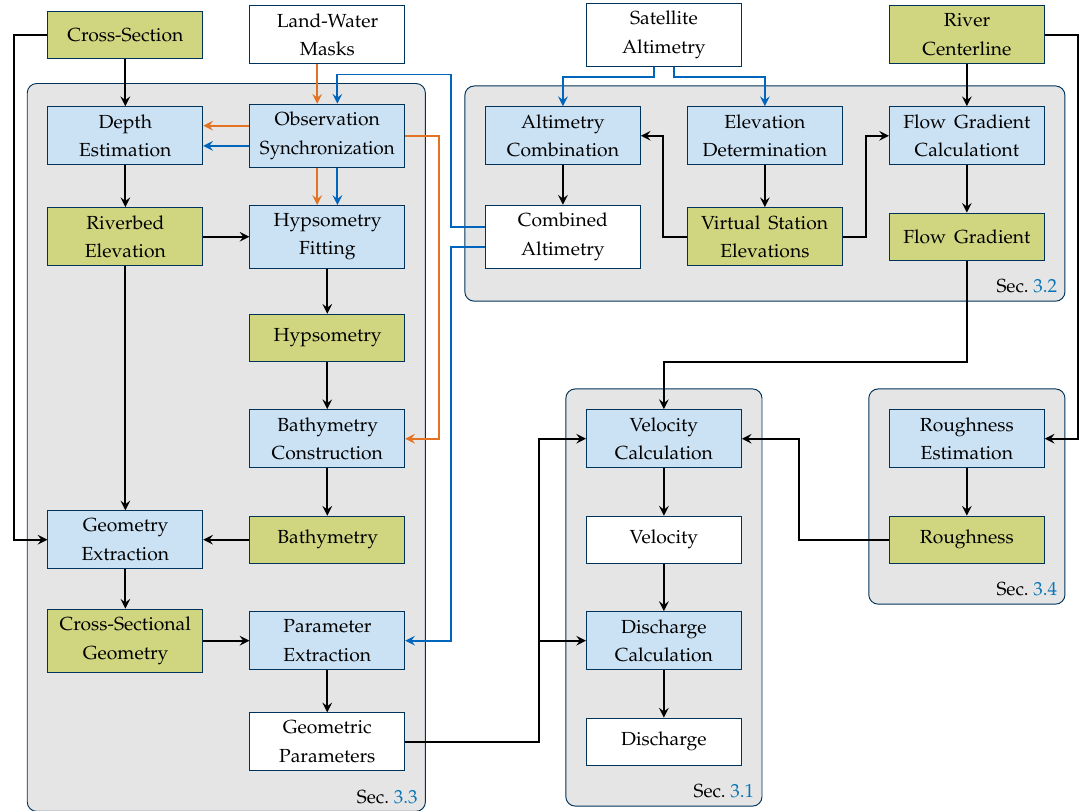
Figure 4. Methodology flowchart with time series data (white), constant data (green), processing steps (blue), and sections (gray). Orange arrows represent data derived from land-water masks and blue arrows represent satellite